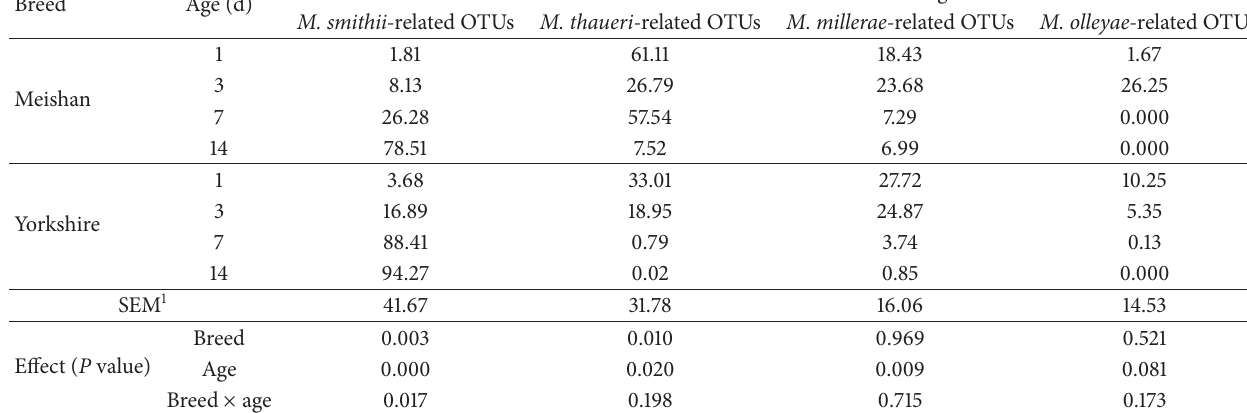
Table 3: Relative abundances (percentage) of M. smithii- , M. thaueri- , M. millerae- , and M. olleyae -related OTUs in the 16S rRNA gene libraries from faecal methanogens of Meishan and Yorkshire piglets. Breed